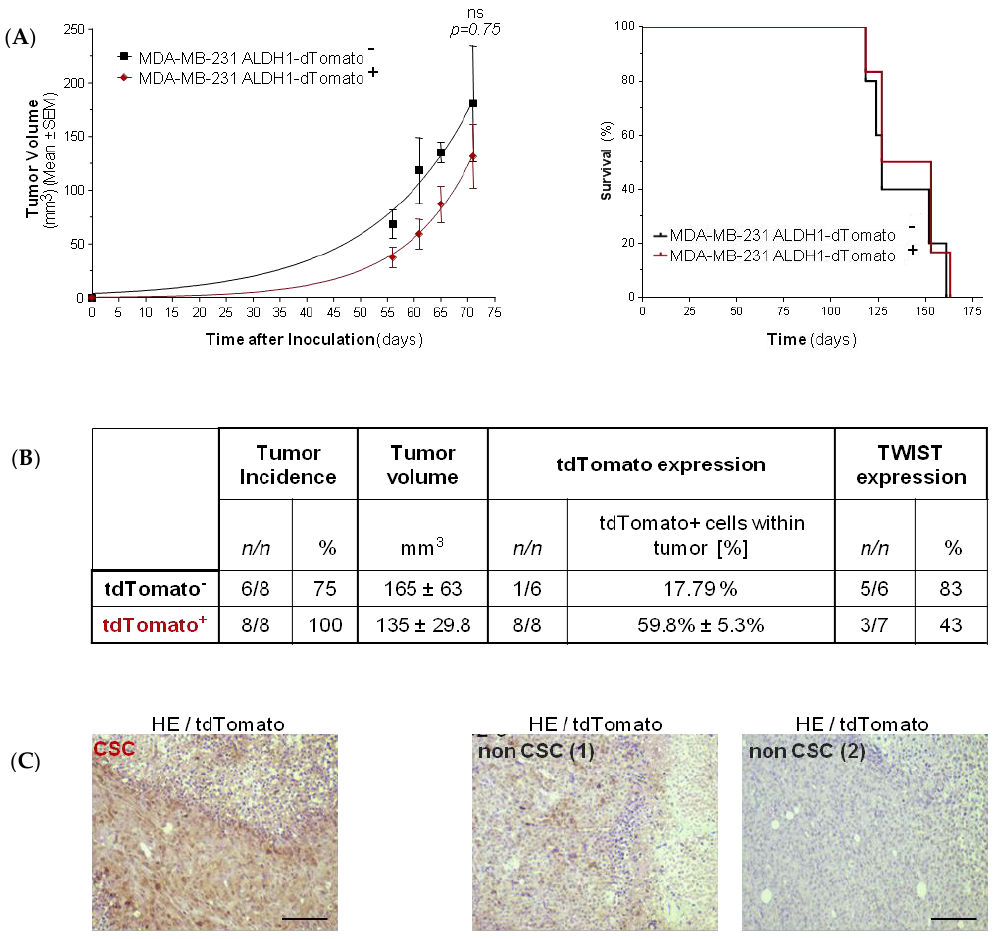
Figure 4. MDA-MB-231 in vivo model. Tumor growth and Kaplan–Meier survival curves of mice inoculated orthotopically into the right mammary fad pad (IMFP) with MDA-MB-231dTomato − non-CSC ( n = 6), and MDA-MB-231dTomato + CSC ( n = 8) cell variants was monitored over time.